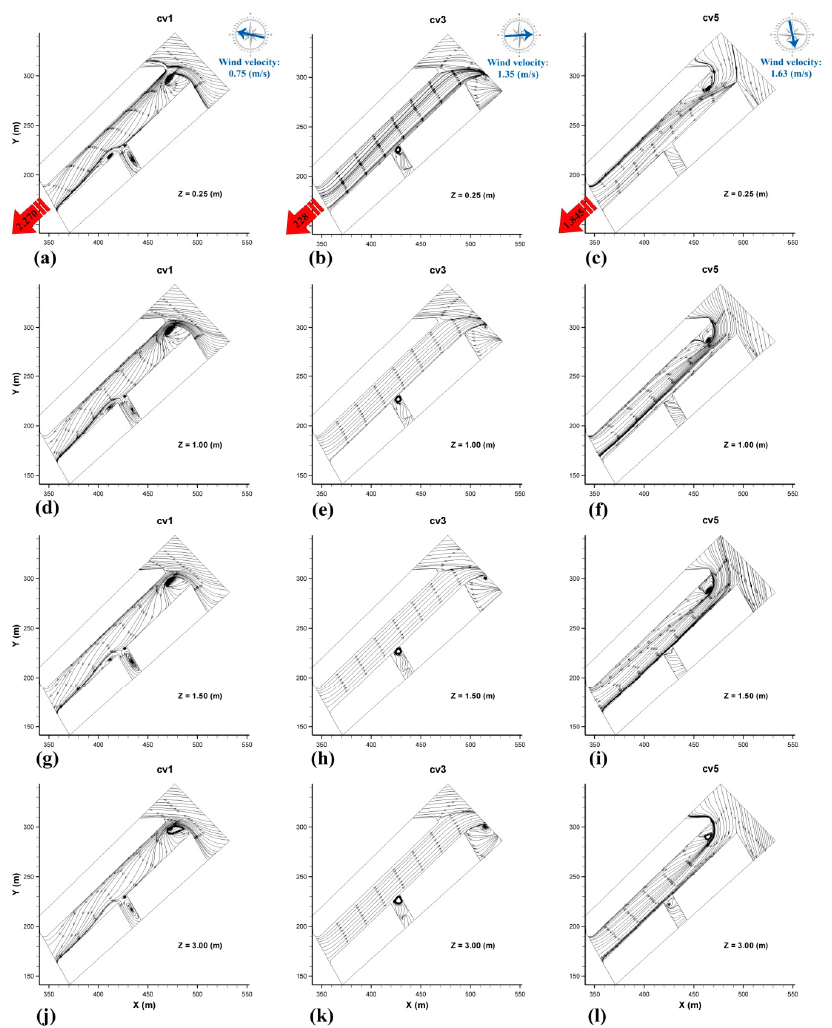
Figure 7. Streamlines at different heights: 0.25 m ( a , b , c ); 1.00 m ( d , e , f ); 1.50 m ( g , h , i ); and 3.00 m ( j , k , l ) for cv1, cv3 and cv5 validation cases, respectively. Atmosphere 2020 , 11 , x FOR PEER REVIEW